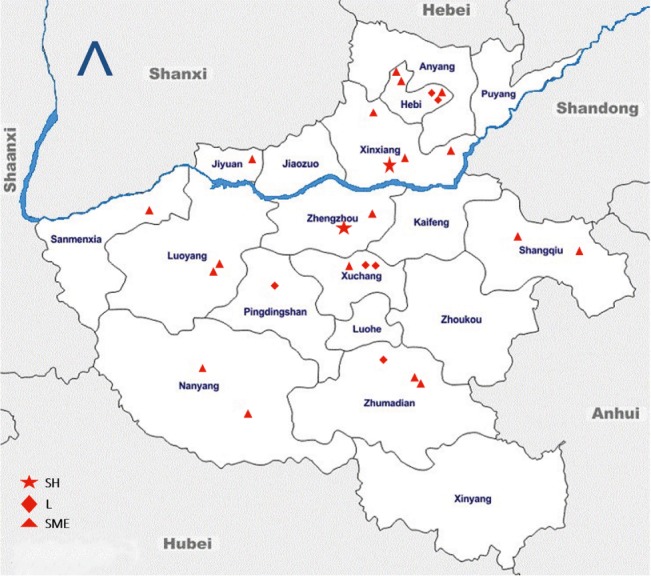
Geographic distribution of the sampling sites across different administrative divisions (or cities) in Henan, China. Sampling sites are denoted as slaughterhouse (SH), large farms (L), and small and medium enterprise farms (SME). The blue line denotes the Huang He river, flowing through the province to the east into the Bohai Sea. The arrow head points to the geographical north. This map is not drawn to scale.